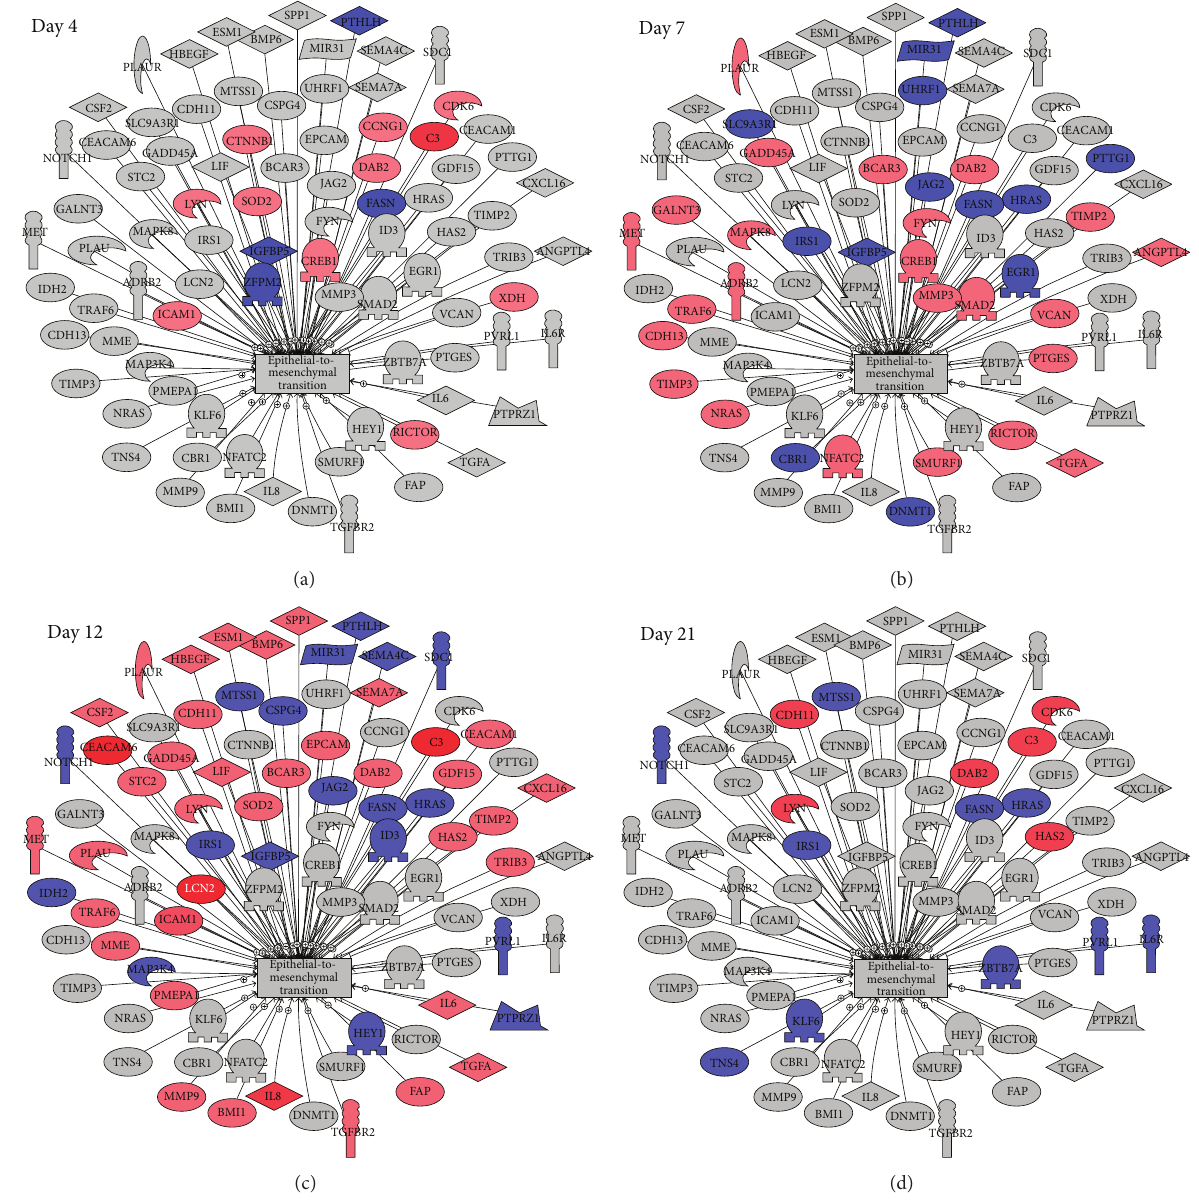
Figure 4: Changes in genes associated with epithelial-to-mesenchymal transition after radiation. Using Pathway Studio, genes known to be associated with epithelial-to-mesenchymal transition and differentially expressed at a minimum of one time point after radiation with a 𝑝 value ≤ 0.01 and fold change (negative or positive) of 1.5 or greater were identified. Red represents genes upregulated after irradiation whilst blue represents downregulated